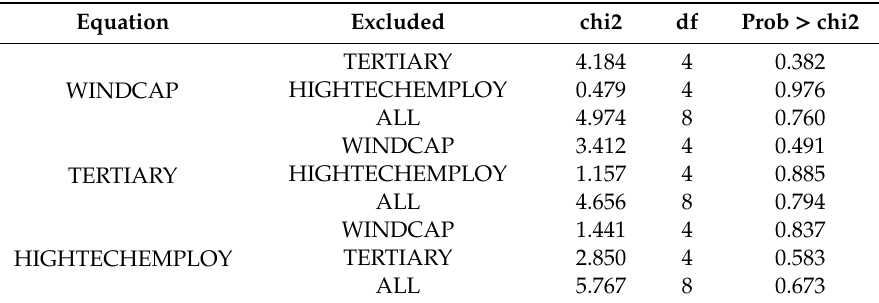
Table 2. Panel VAR–Granger causality Wald test.